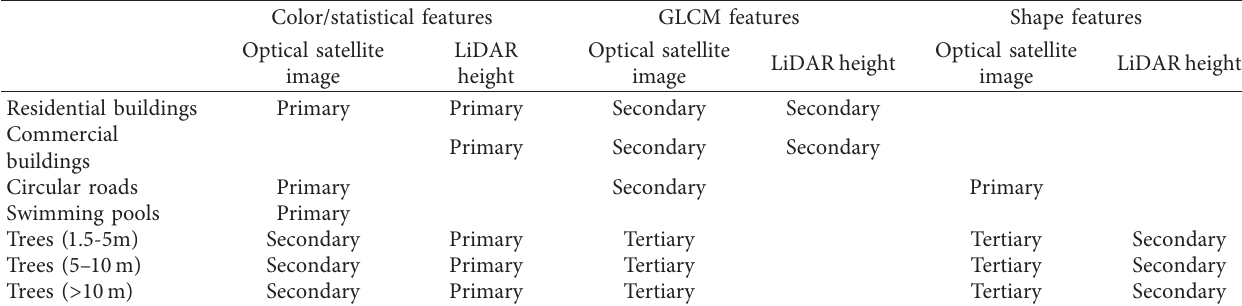
Table 3: Priority of low-level features defined from the first experimental datasets.